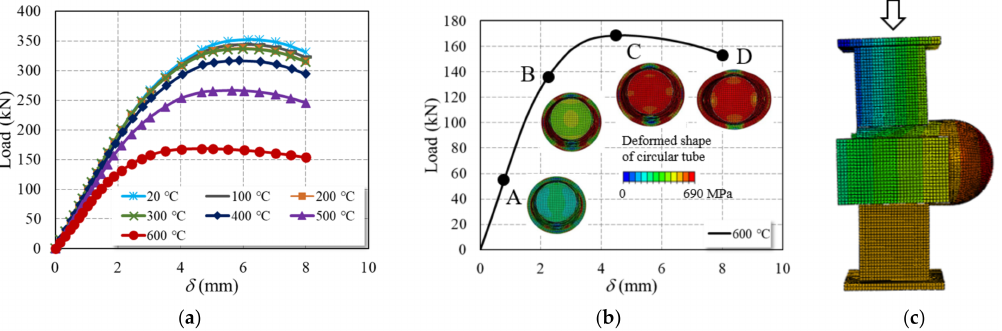
Figure 8. Effects of elevated temperatures on the load–displacement curves of specimen N1 under compression: ( a ) load–displacement curves; ( b ) failure process; ( c ) deformed shape corresponding to point C.